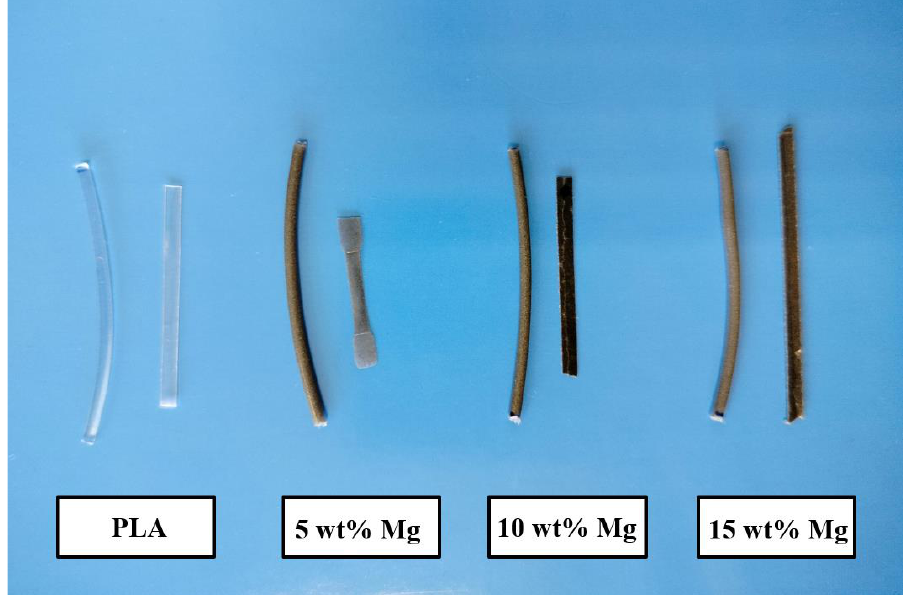
Figure 2. Digital photo of the different filaments and the corresponding 3D printing pieces.